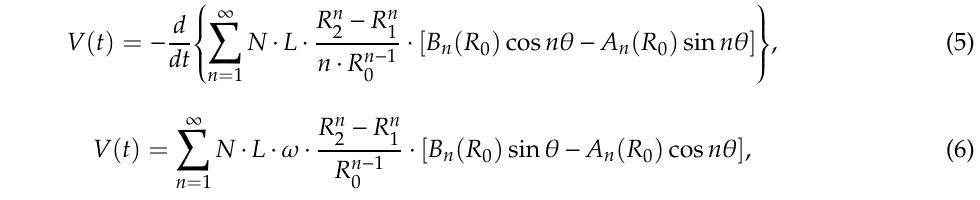
4 of 16 Figure 2. ( a ) Normal dipole signal; ( b ) skew dipole signal. From Equation (1) and Figure 2, the electromotive force obtained from the search coil can be